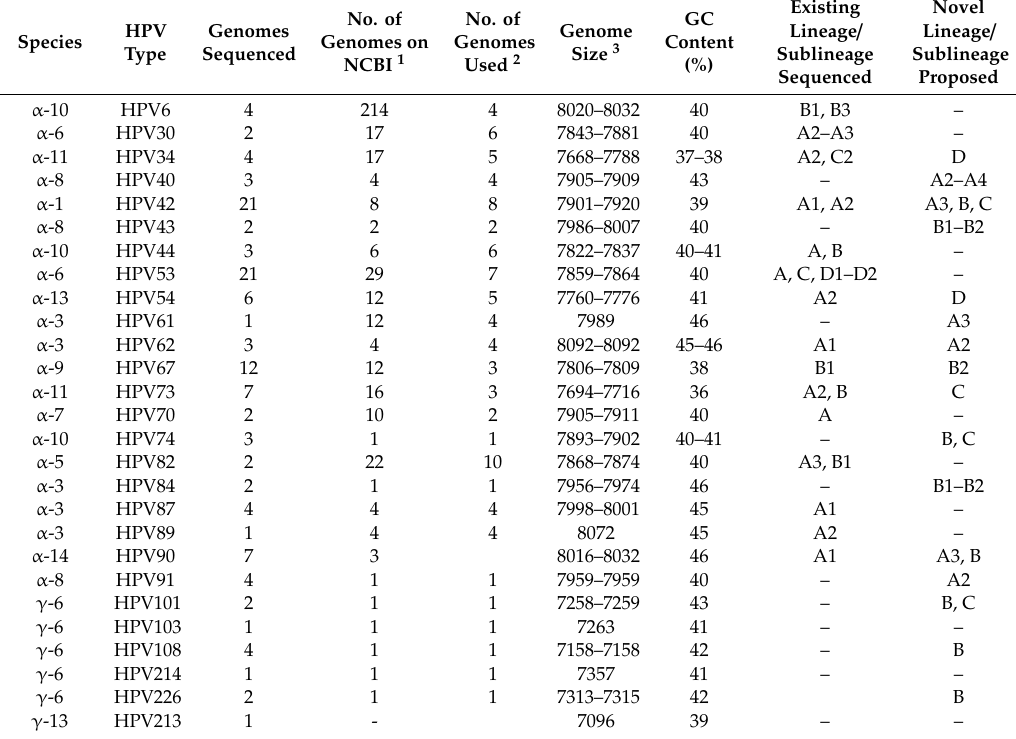
Table 4. Classification of low-risk complete HPV genomes sequenced in our